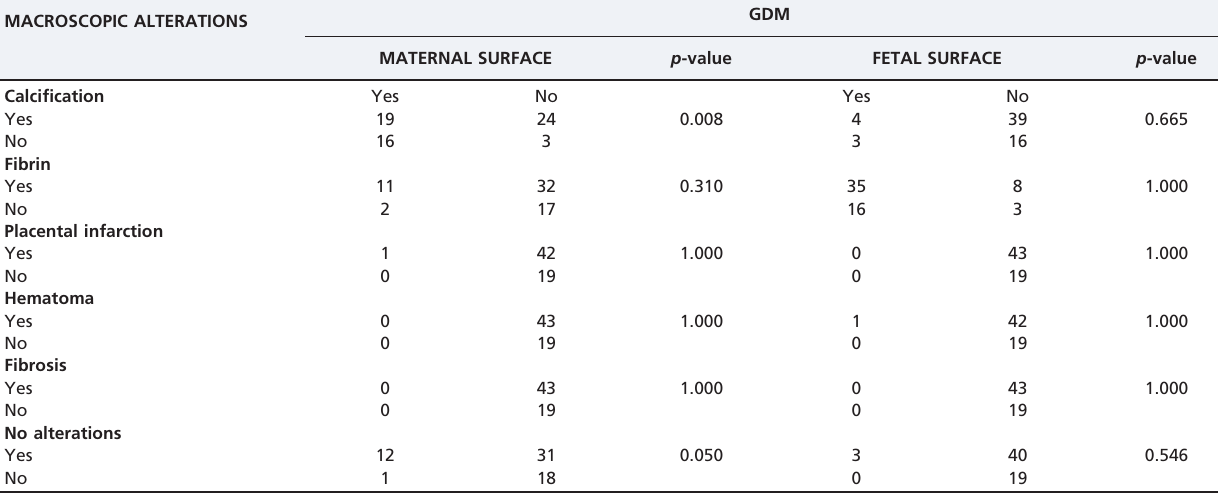
Table 3 - Association between macroscopic changes on the fetal and maternal placental surfaces and gestational diabetes mellitus in 43 women from Goiaˆnia, Central-West Brazil, between August 2009 and July